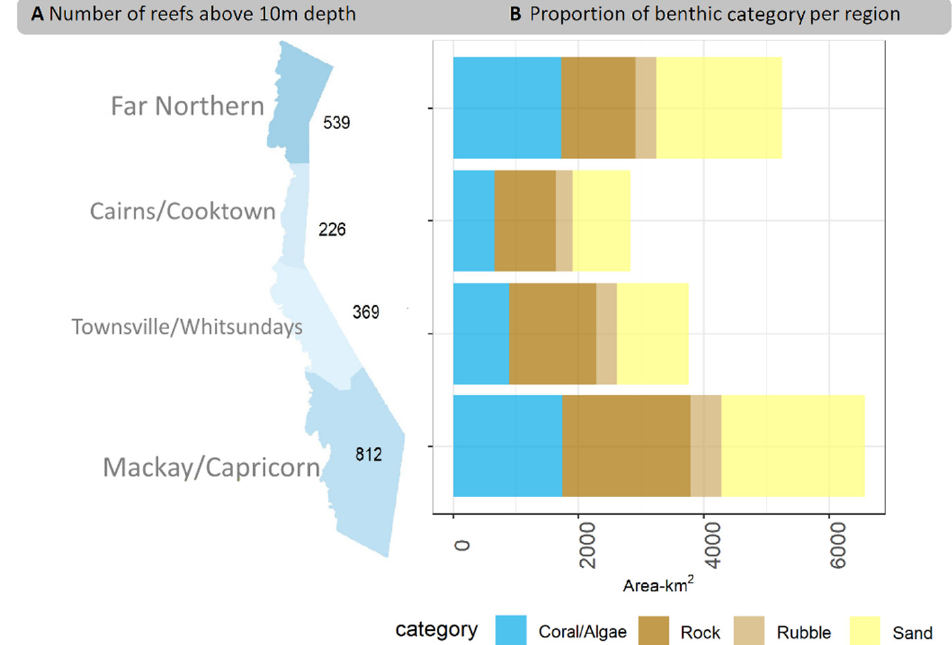
Figure 5. ( A ) Total number of offshore reefs mapped above 10 m depth used for estimation of benthic category areas across management regions. ( B ) Surface area per benthic category (coral/algae, sand, rock and rubble) per region.